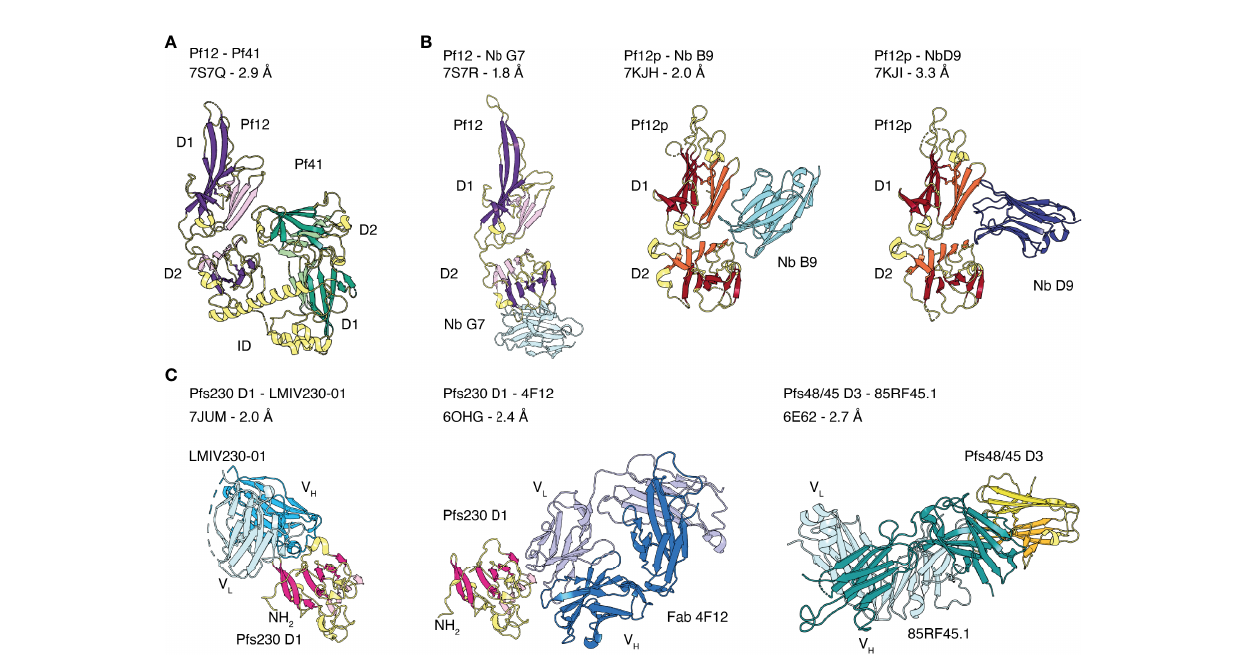
FIGURE 3 | Crystal structures of the 6-cysteine proteins of P. falciparum in complex with another 6-cysteine protein or antibody fragments. (A) Crystal structure of the hetero-dimeric complex of Pf12 and Pf41 with indicated D1 and D2 domains and the inserted domain-like region (ID) of Pf41. (B) 6-cysteine proteins bound to nanobodies. Pf12 bound to Nb G7 (left), Pf12p bound to Nb B9 (middle) and Nb D9 (right). (C) 6-cysteine protein domains bound to Fab and single-chain fragment variable (scFv) regions. Pfs230 D1 in complex with scFv of LMIV230-01 (left) and Fab of 4F12 (middle). Pfs48/45 D3 bound to Fab of 85RF45.1